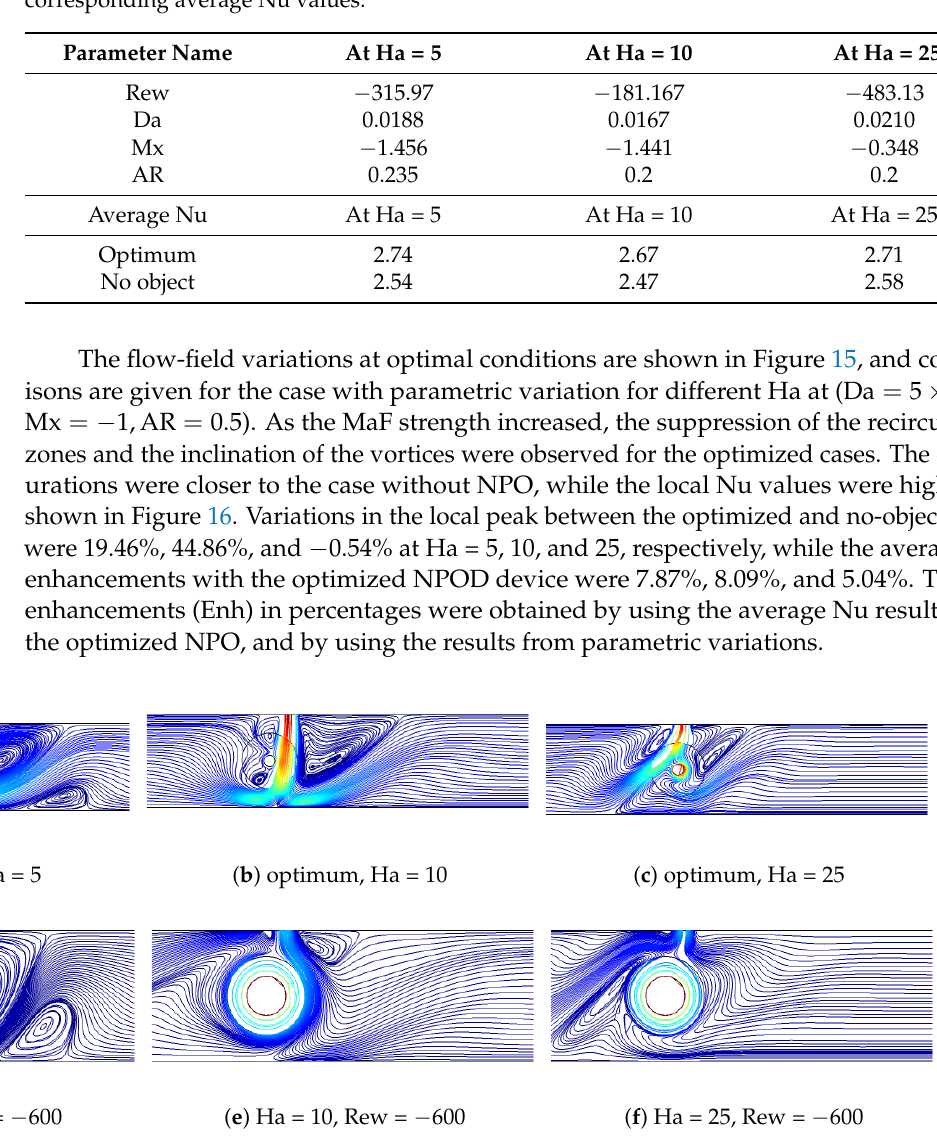
Table 2. Optimal set of parameters for the maximal average Nu at different MaF strength levels and corresponding average Nu values.